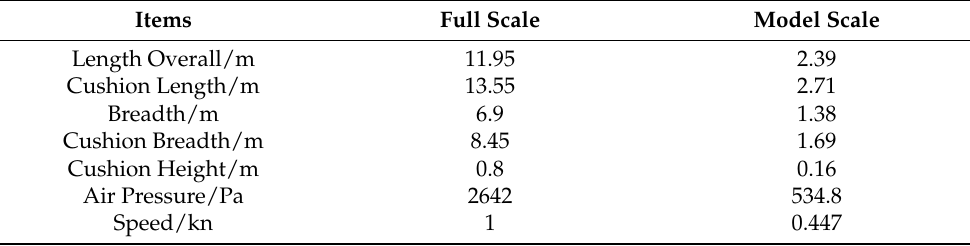
Table 1. Main parameters of the